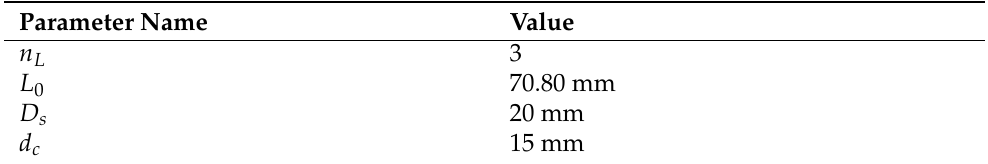
Table 1. Actuator design